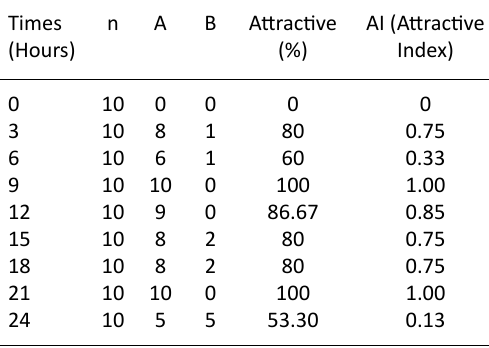
Table 2. Biological Activity Assays of the crude acetone extract in the warehouse ( S. oryzae L) samples